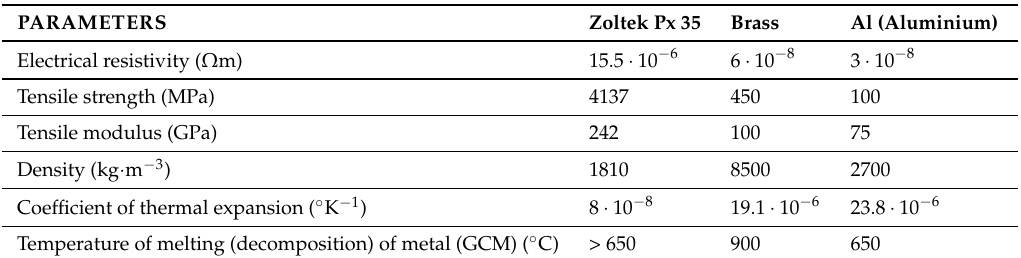
Table 2. Main properties of graphene-containing composite material antennas and corresponding metal